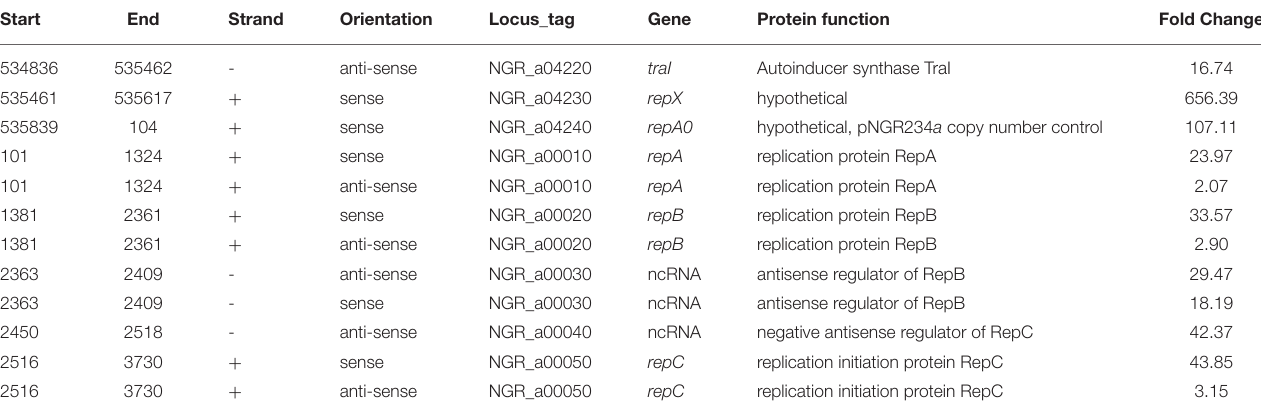
TABLE 4 | Fold-increase of genes associated with the repABC locus replication in the background of the NGR234- △ traI - △ ngrI mutant compared to the wild type strain and as estimated using RNA-seq.